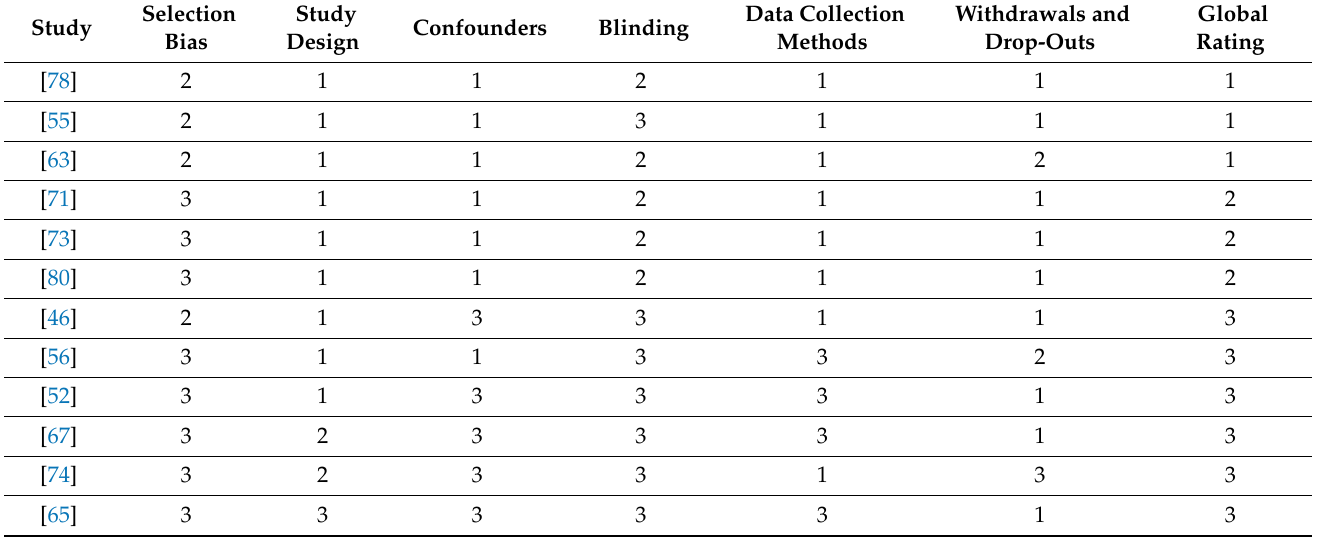
Table 2. Quality appraisal of quantitative studies (EPHPP) ( n = 12 )